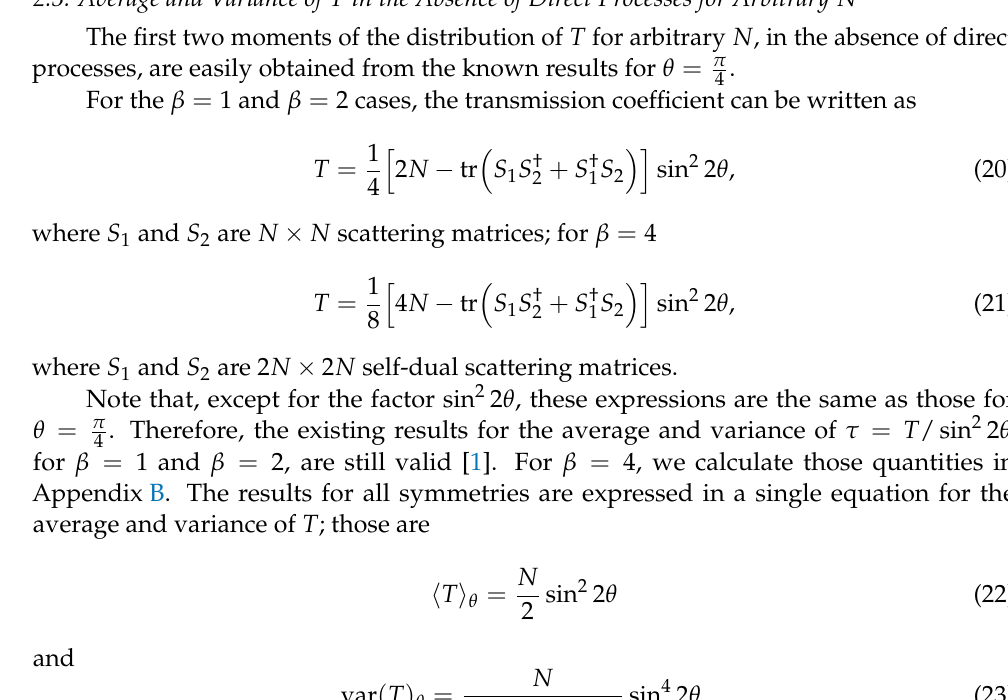
Figure 2. (Color online) Dimensionless conductance distribution for N = 2 and θ = 3 absence of direct processes. The histograms corresponds to random-matrix theory simulations for each symmetry class; the continuous lines correspond to Equations (18) and (19) for β = 1 (left panel) and β = 2 (middle panel),